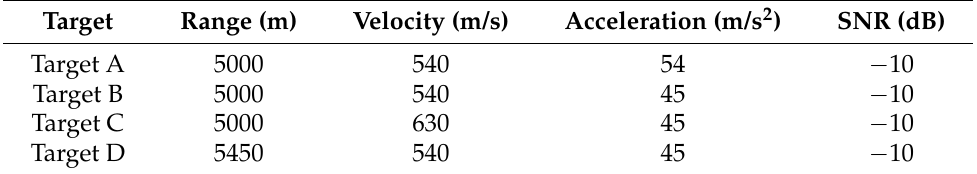
Table 4. Parameters of the four